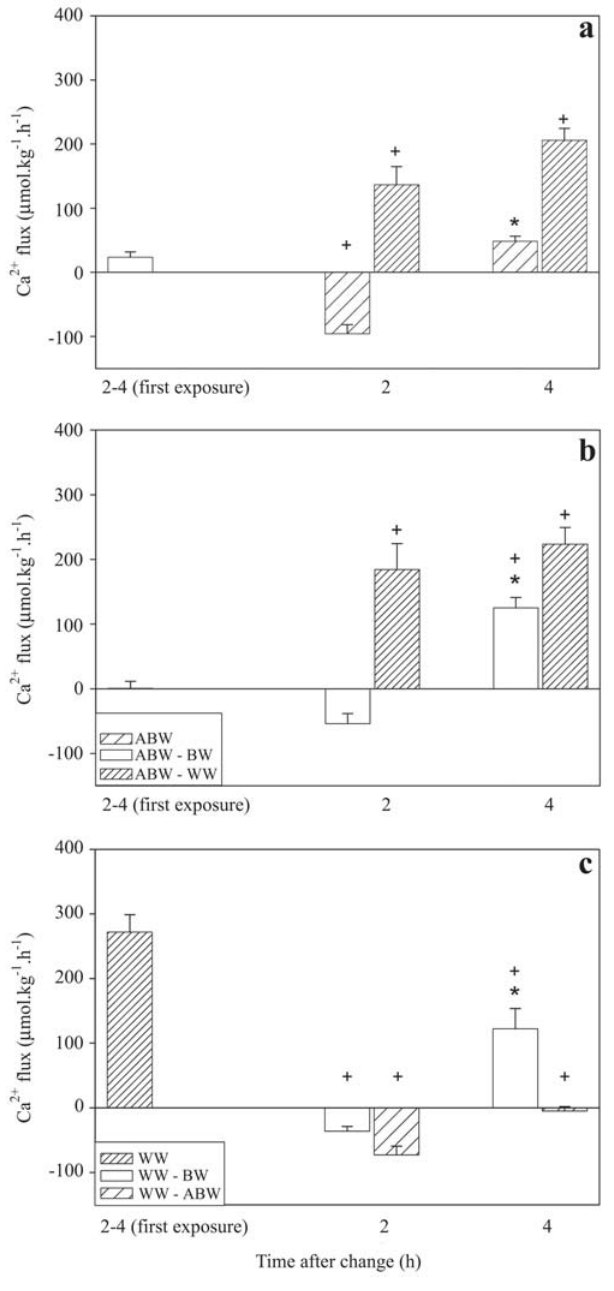
Fig. 3. Net Ca 2+ fluxes of Hoplosternum littorale transferred from black water (BW) to acidic black water pH 3.5 (ABW) or white water (WW) (a), and fish transferred from ABW to BW or WW (b) and fish transferred from WW to BW or ABW (c). The first bar in the left side of the figure represents the 2-4 h flux of the first exposure. Data expressed as mean ± SEM. Positive values indicate net influxes and negative values net effluxes. Asterisks (*) indicate significantly different from the same group 2 h after transfer by Kruskall- Wallis ANOVA and Mann-Whitney test (P < 0.05). Crosses (+) indicate significantly different from the previous water condition by Kruskall-Wallis ANOVA and Mann-Whitney test (P <